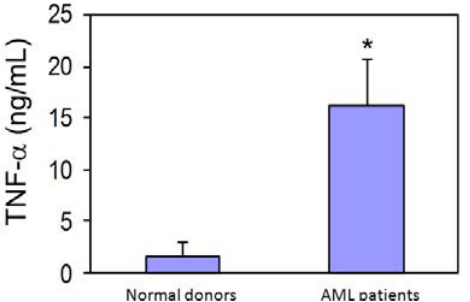
Figure 3. TNF- α levels in media conditioned by MNC from normal donors and AML patients as evaluated by ELISA. * p ≤